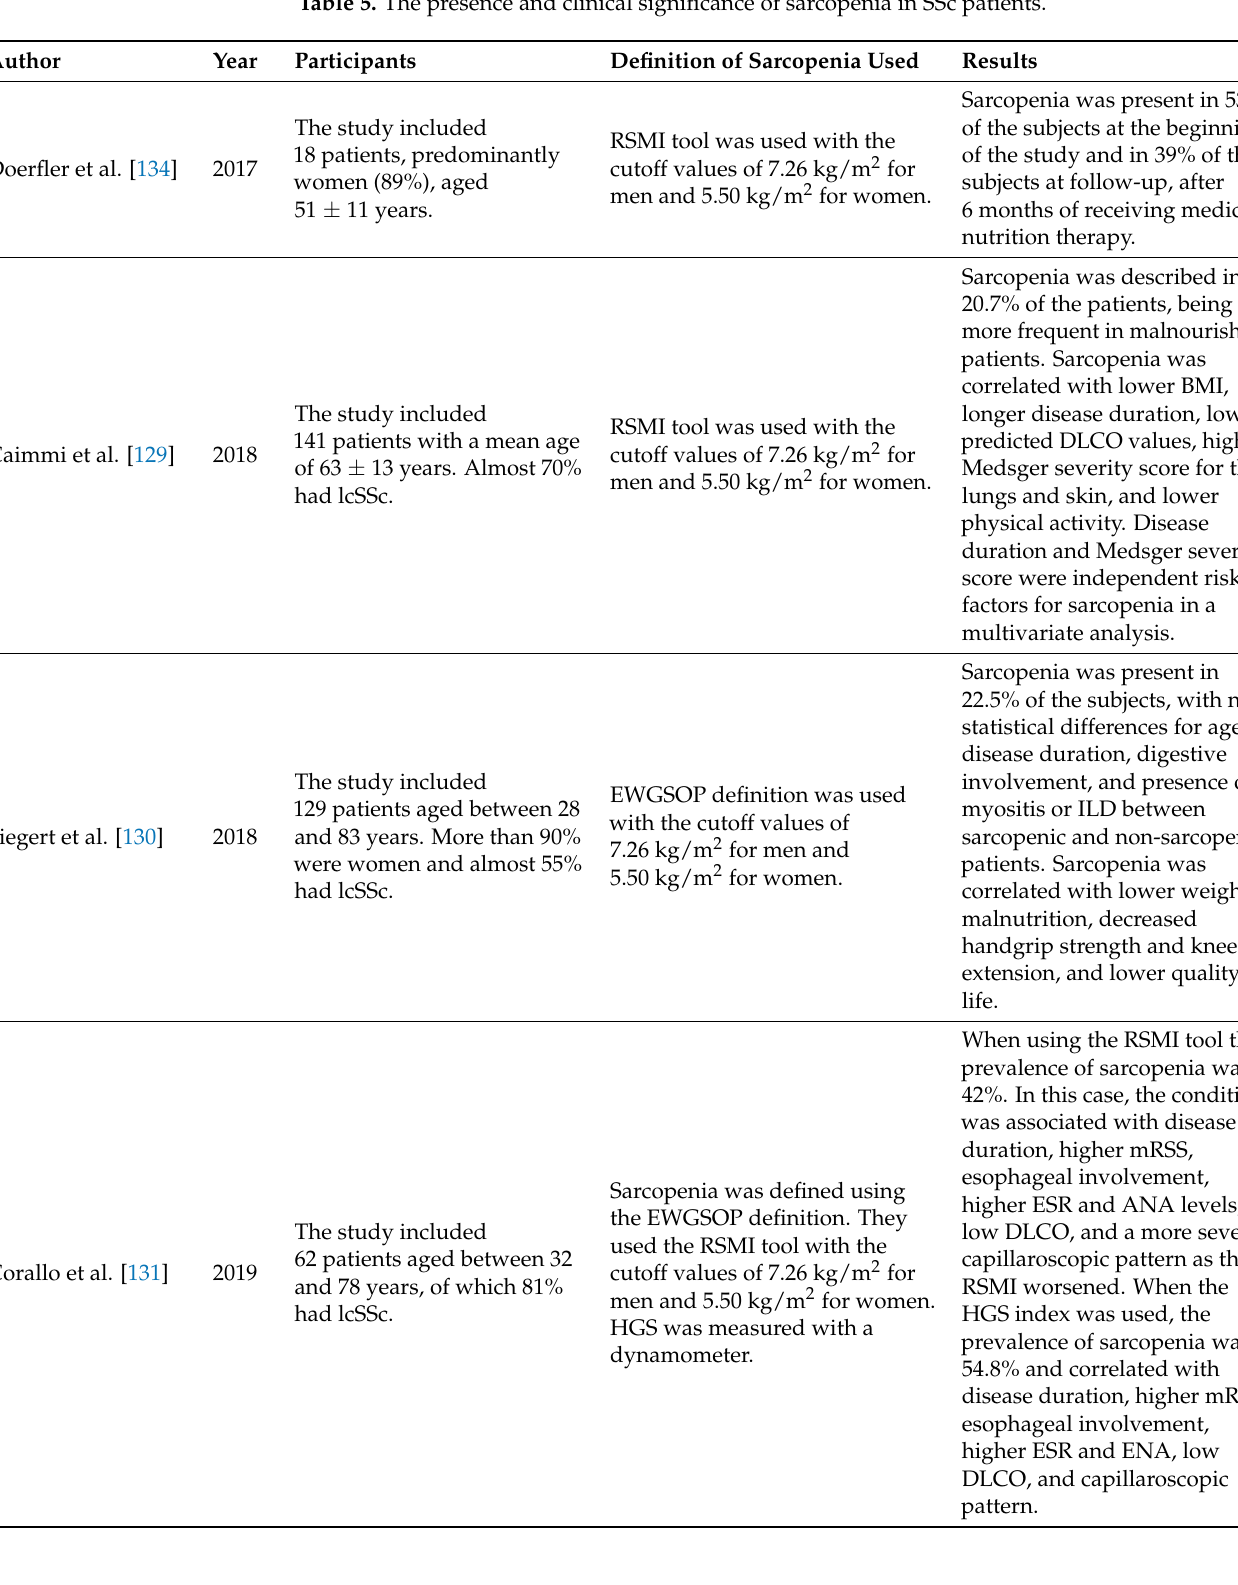
Table 5. The presence and clinical significance of sarcopenia in SSc